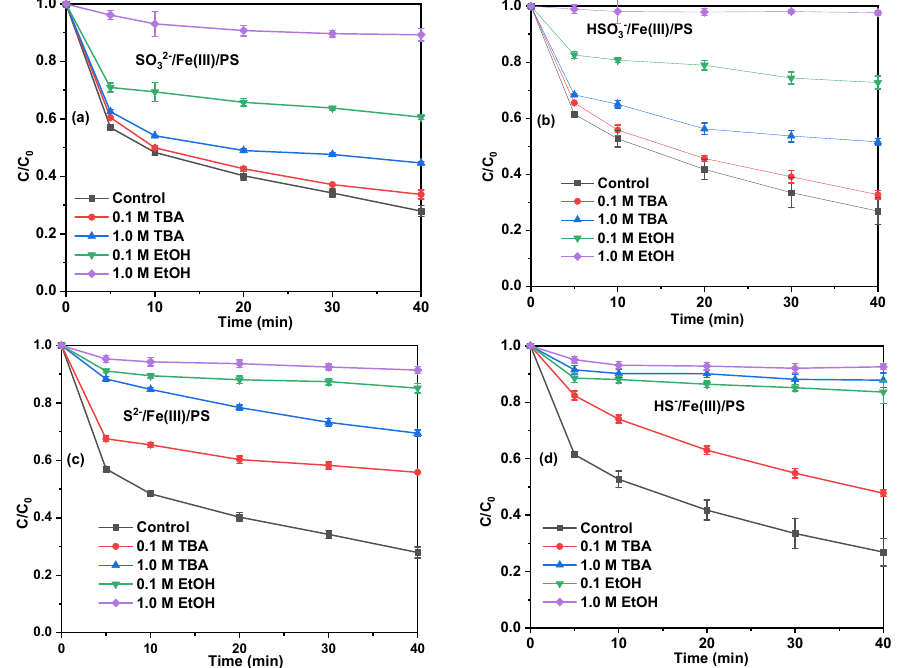
Figure 5. Effect of different quenchers on the removal efficiency of BPA in the SO 32− /Fe(III)/PS ( a ); HSO 3− /Fe(III)/PS ( b ); S 2− /Fe(III)/PS ( c ) and HS − /Fe(III)/PS ( d ) system. Reaction conditions: [Fe(III)] = 1.0 mM, [SO 32− ] = [HSO 3− ] = [S 2− ] = [HS − ] = 1.0 mM, [PS] = 4 mM, [BPA] = 10.0 mg/L.